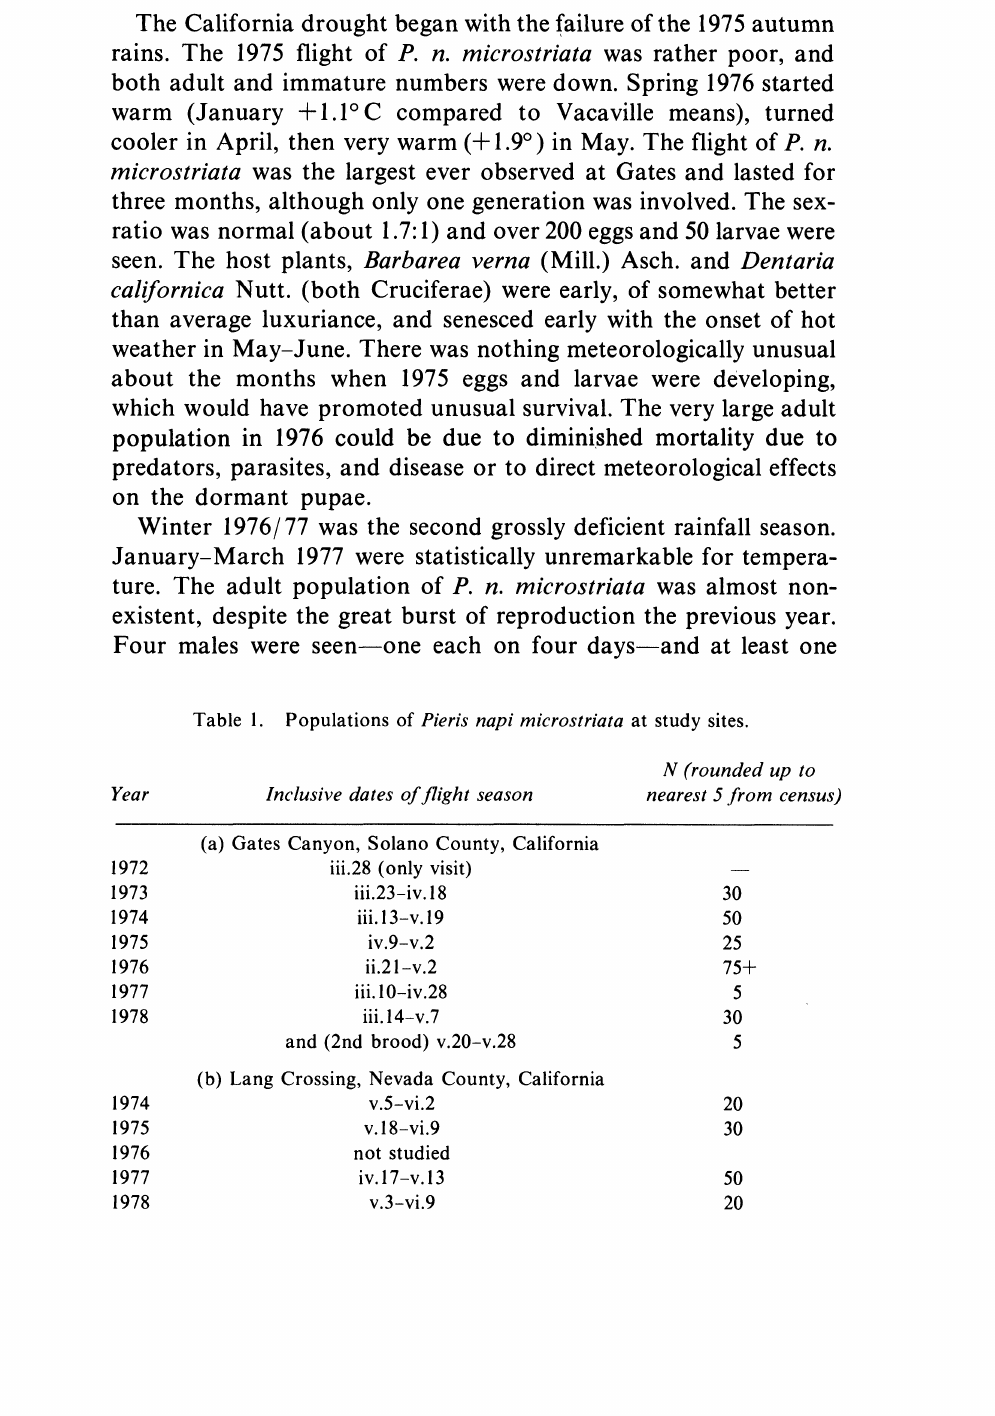
N (rounded up to nearest 5 from